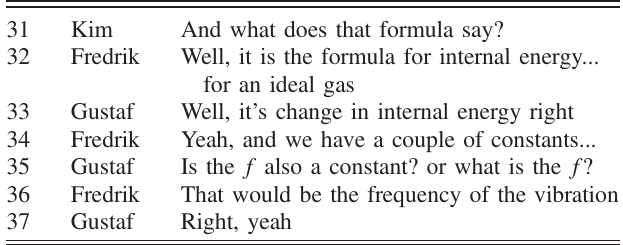
TABLE VI. Transcript of a conversion between peers. Con- tinuation of Table